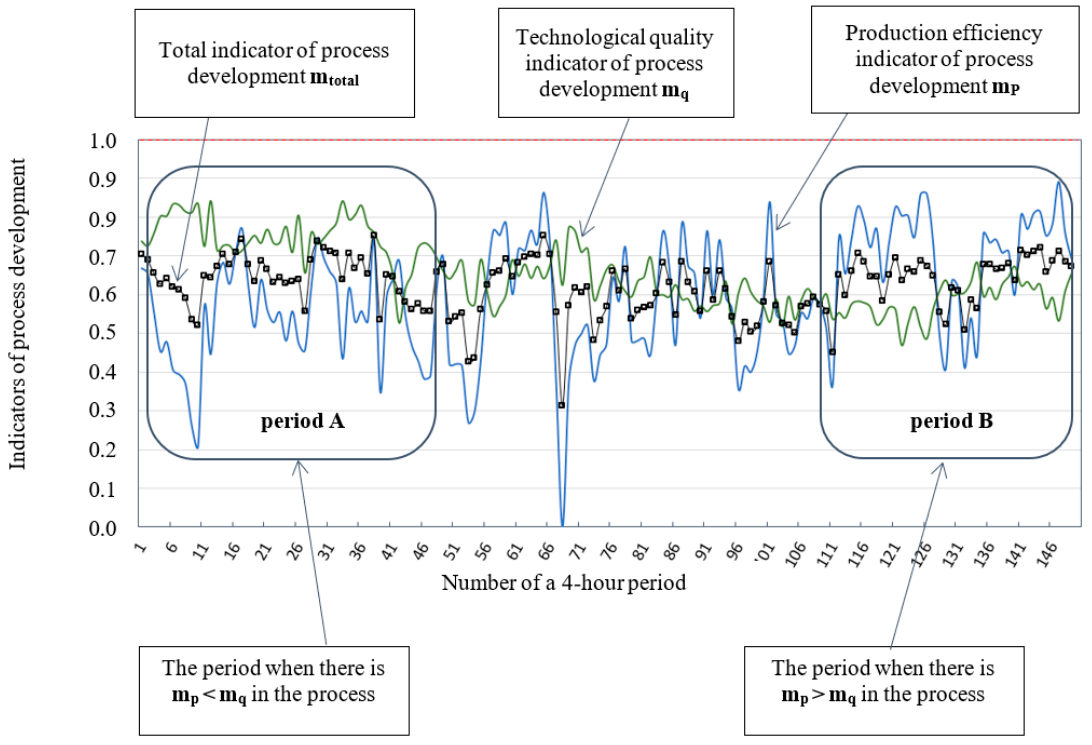
Figure 2. Trend graph of total indicator m total , technological quality indicator m q and production e ffi ciency m p of process development (4-h periods registered within 1 month).